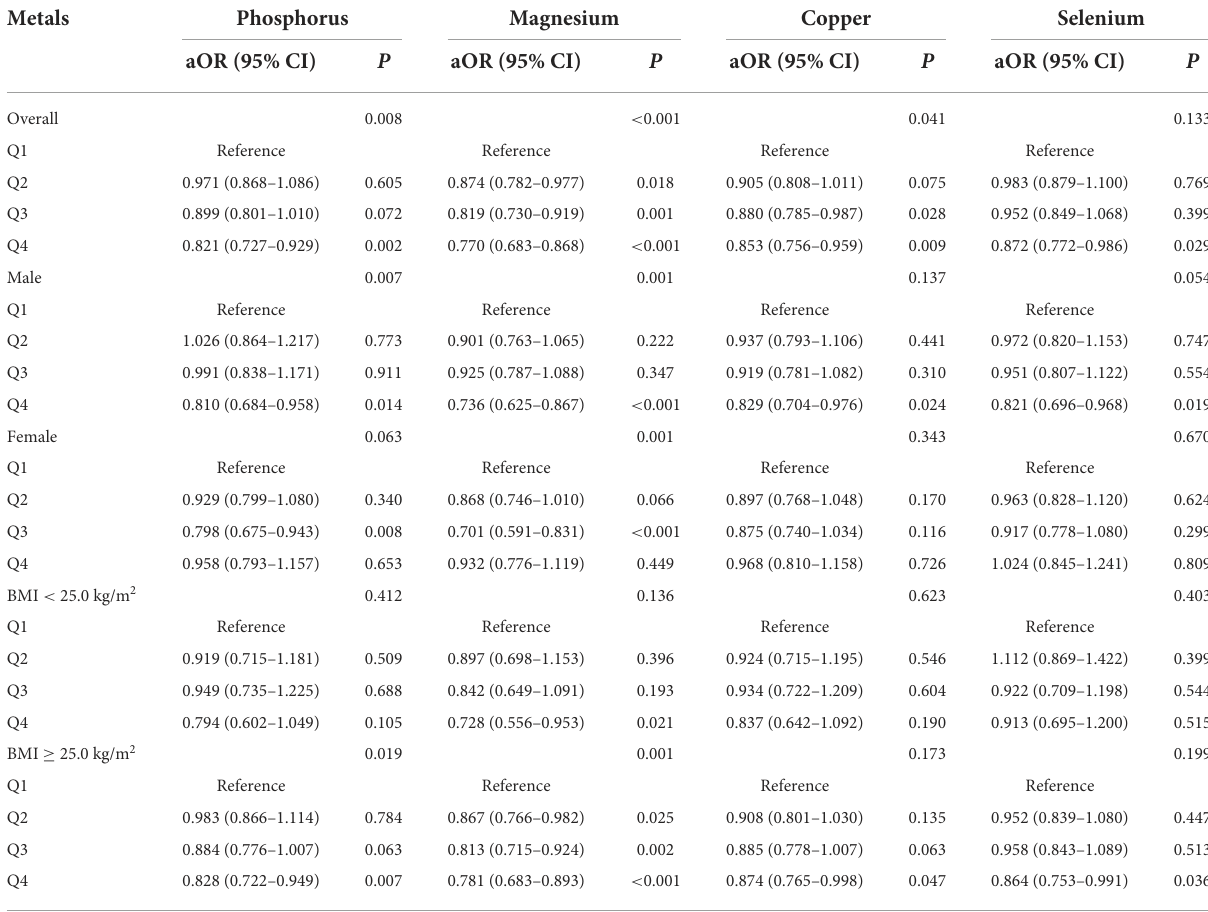
TABLE 2 Multivariate single-metal model logistic regression the relationship between the heavy metals and the presence of kidney